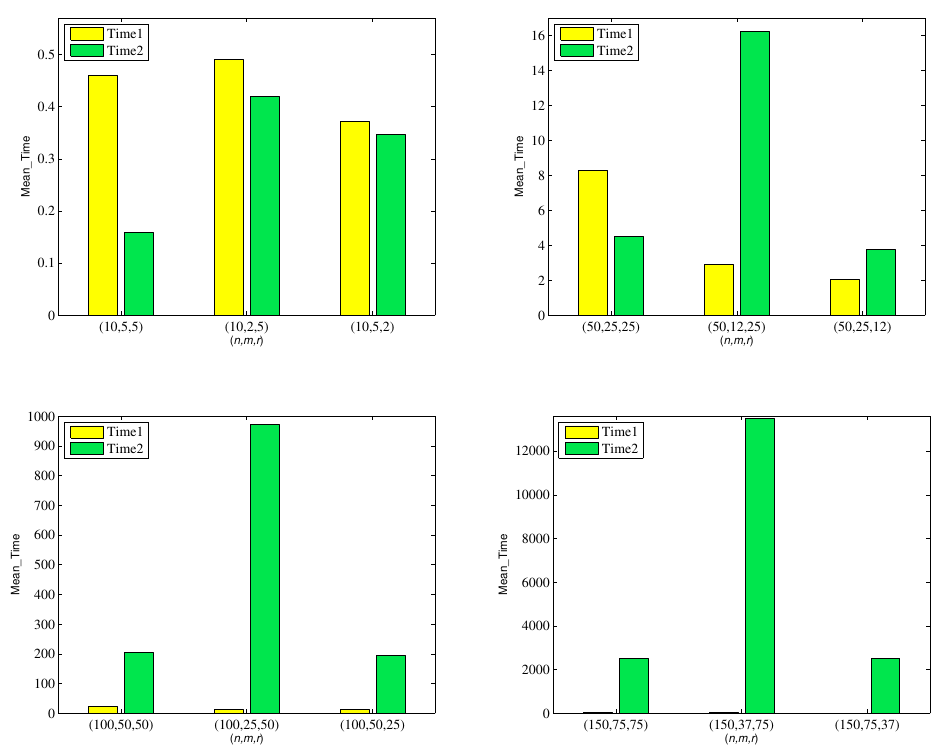
Figure 3. Mean value of computing times with different ( n,m,r ) sets.